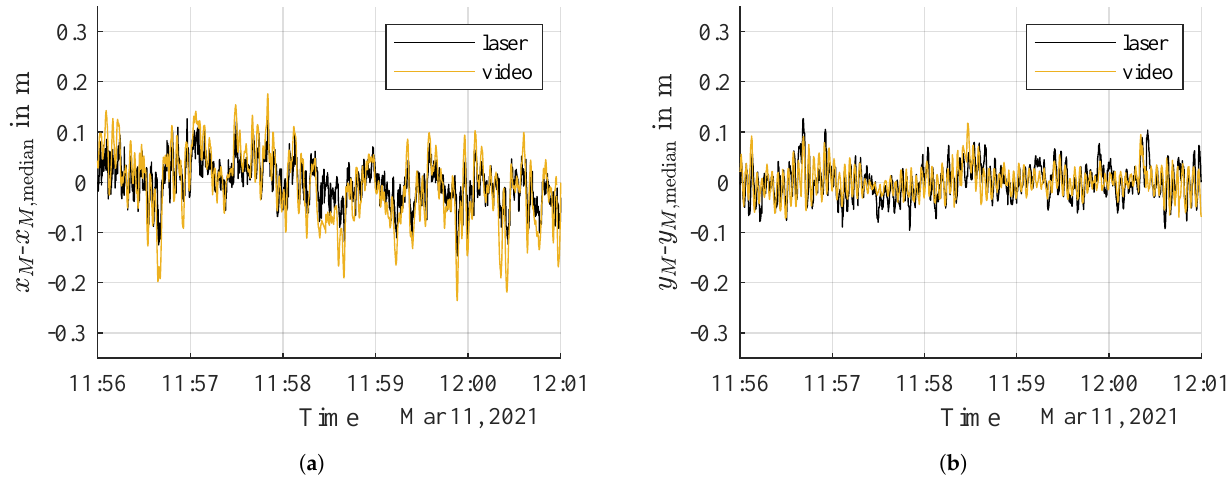
Figure 10. Tower movement in the lateral and axial direction measured by the laser scanner and video recording during strong wind conditions. ( a ) Tower movement in the lateral direction ( x M ). ( b ) Tower movement in the axial direction ( y M